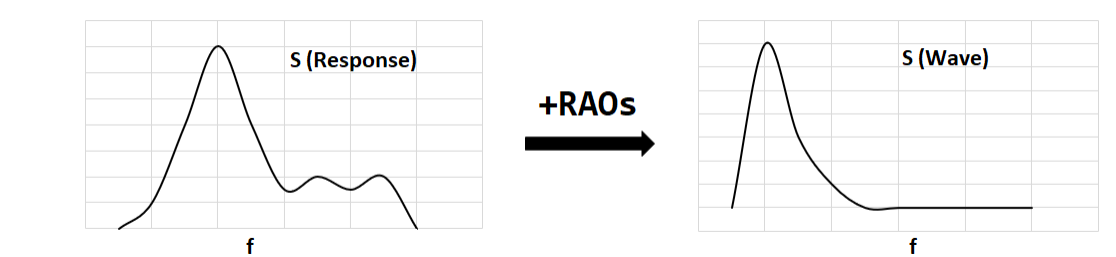
Figure 5. Illustration of the main idea of DWS estimation formulated in the frequency